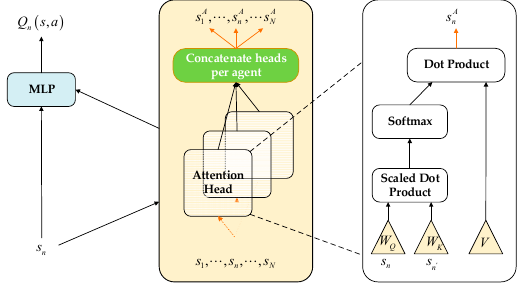
Figure 3. The basic AMARL for V2X communications.